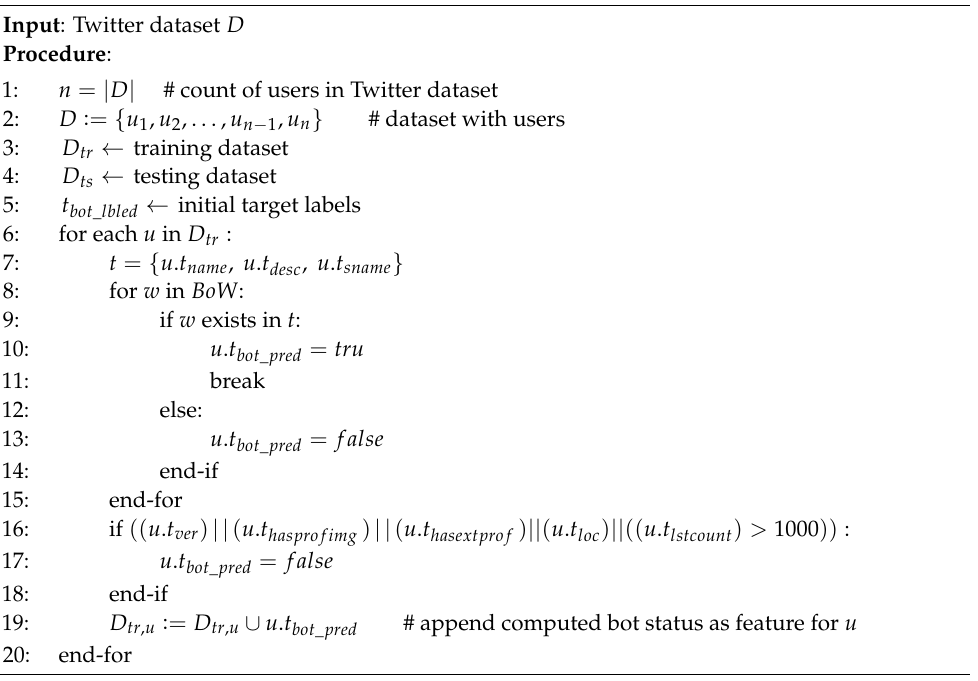
Algorithm 1: Proposed TweezBot